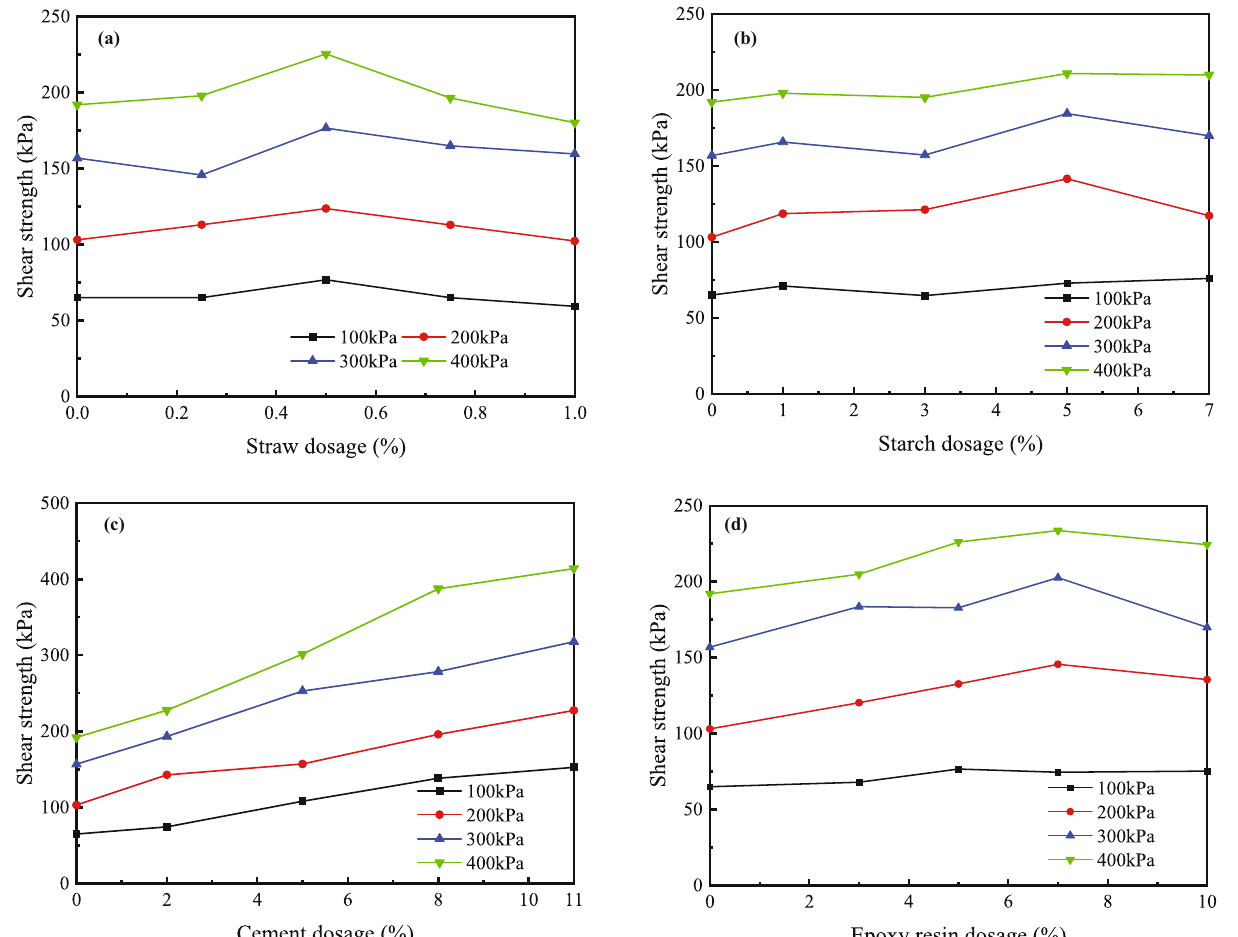
Figure 12: Change in shear strength of yellow mud with di ff erent material contents: ( a ) straw; ( b ) starch; ( c ) cement; and ( d ) epoxy